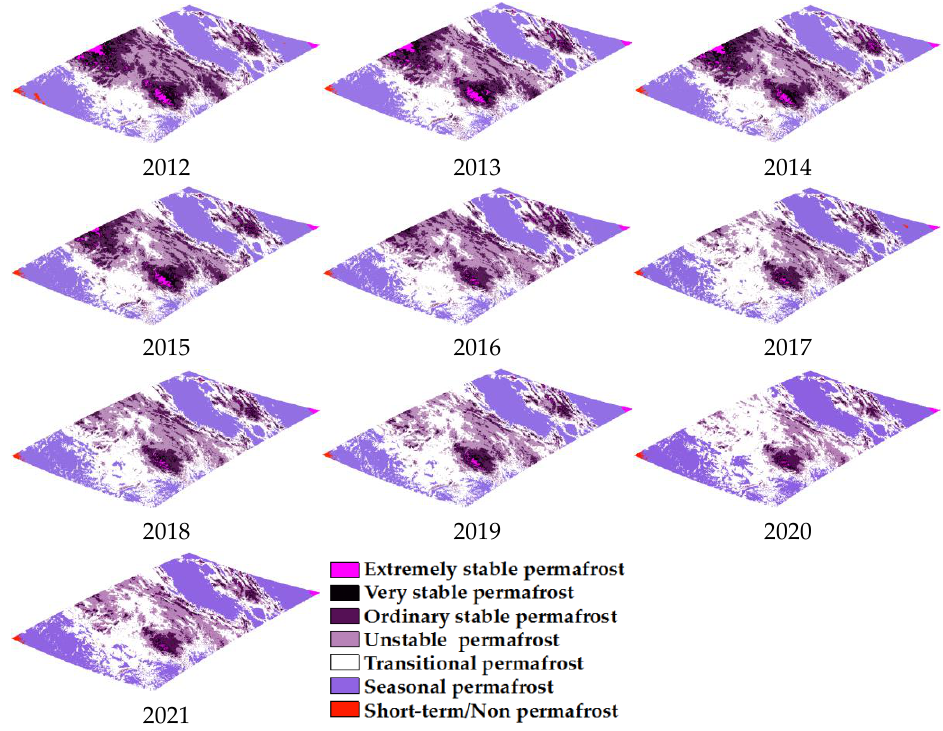
Figure 13. Permafrost distributions classified into seven classes (extremely stable, very stable, ordinary stable, unstable, transitional, seasonal, and short-term/non-permafrost) for each year from 2012 to 2021.